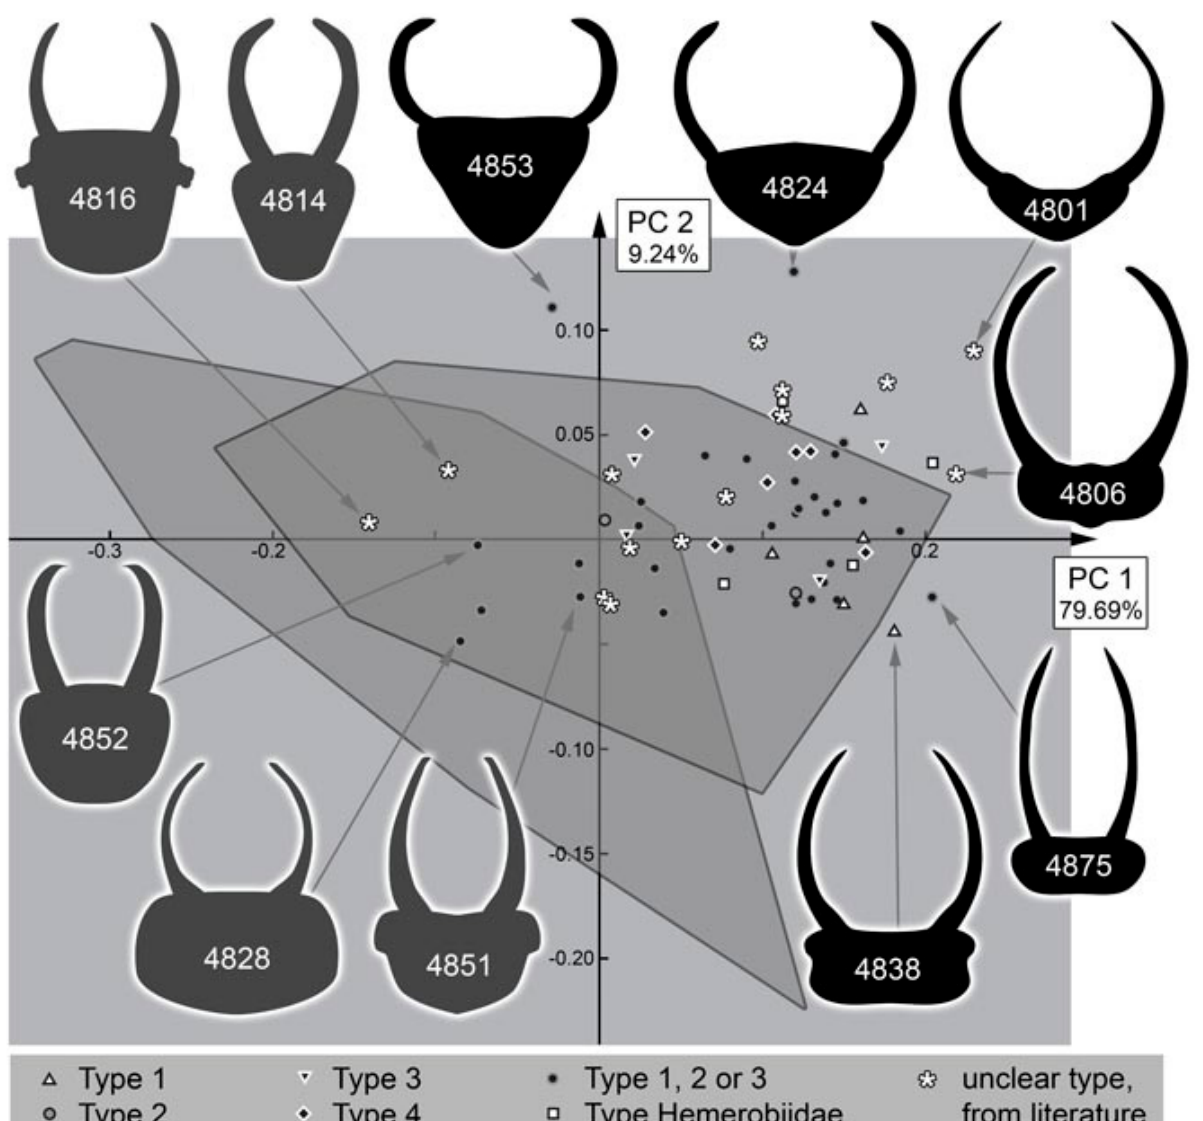
Figure 54. Scatter plot of PC2 vs. PC1 of head shapes of extant and fossil aphidlions and aphidlion- like larvae, continued. Polygons mark areas occupied by modern representatives of Chrysopidae and Hemerobiidae (as in Figure 52); data points of extant, Miocene and Eocene specimens are omitted. Note that many larvae from the Cretaceous plot well within the area of the modern forms (head shapes exemplified by grey outlines), yet some do not (head shapes exemplified by black outlines).